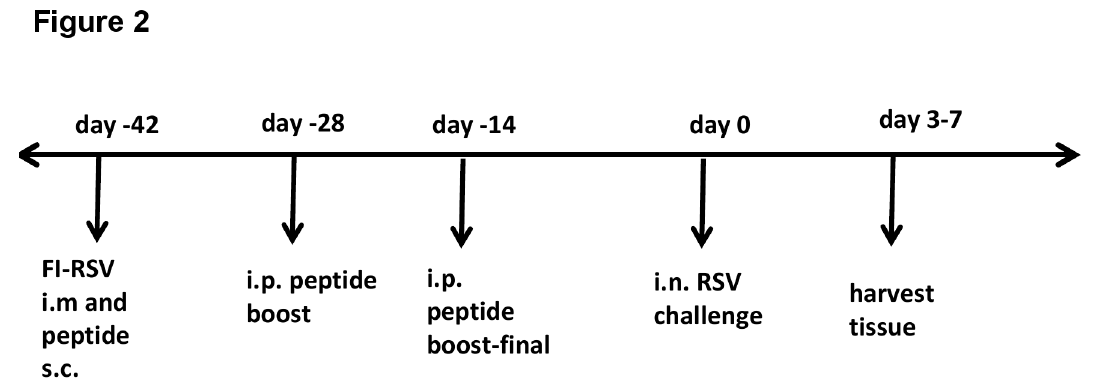
Figure 2. Immunization and challenge timeline. Timeline of vaccination and challenge schedule as described in the Materials and